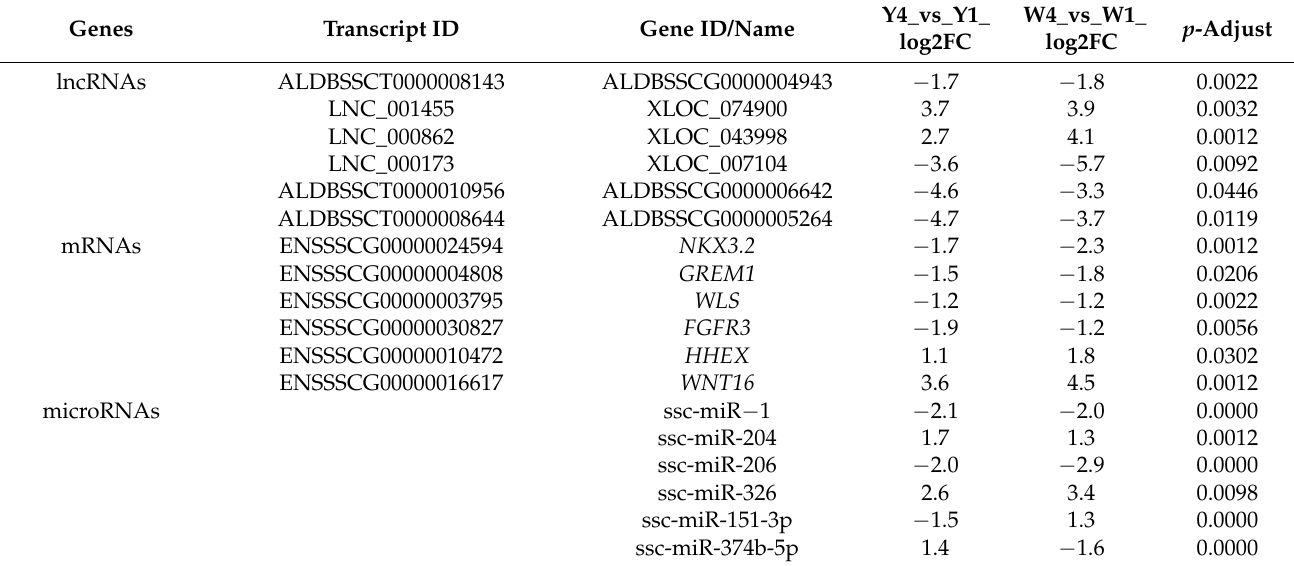
Table 3. Differentially expressed lncRNAs, mRNAs, and microRNAs between different ages in two pig